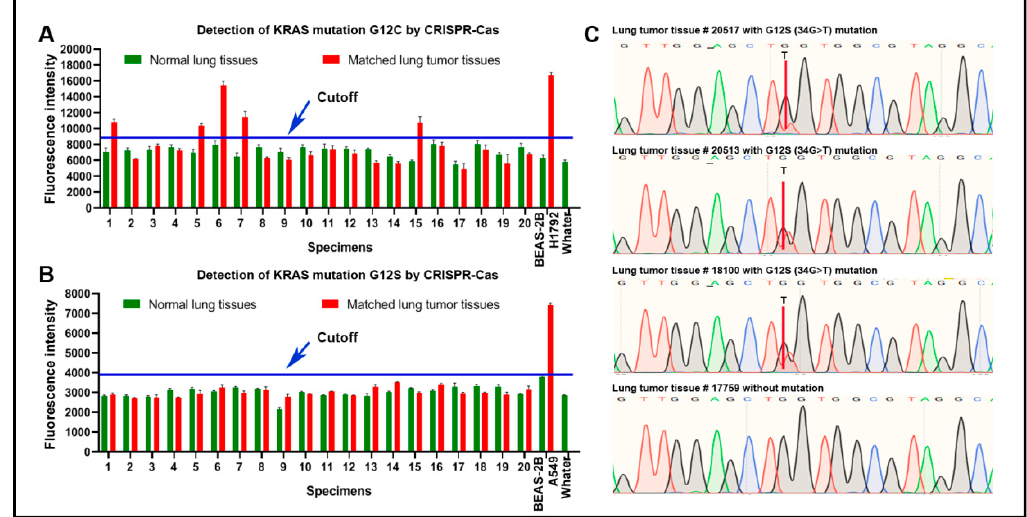
Figure 5. The sensitivity of CRISPR–Cas12a in comparison with direct DNA sequencing analysis of 20 pairs of lung tumor and normal lung tissues: ( A ) CRISPR–Cas12a could detect G12C mutation in five of 20 lung tumor tissues. H1792 cells carrying the G12C mutation were used as a positive control. BEAS-2B cells were used as a negative control; ( B ) there was no G12S mutation by CRISPR–Cas12a in the lung tumor tissues. A549 cells carrying G12S were used as a positive control. BEAS-2B cells were used as a negative control; ( C ) representative tumor tissue specimens (#20517, 20513, and 18100) that were positive for G12C mutation by CRISPR–Cas12a were also positive by DNA sequencing. A representative tumor tissue sample (#17759) that was positive for G12C mutation by CRISPR–Cas12a was negative by DNA sequencing.